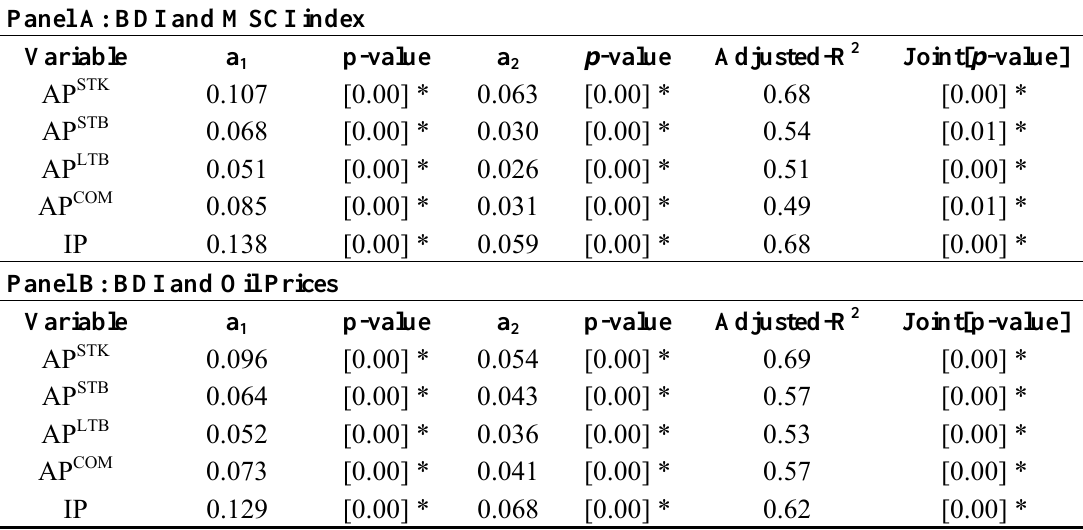
Table 6. Extended model FMOLS long-run